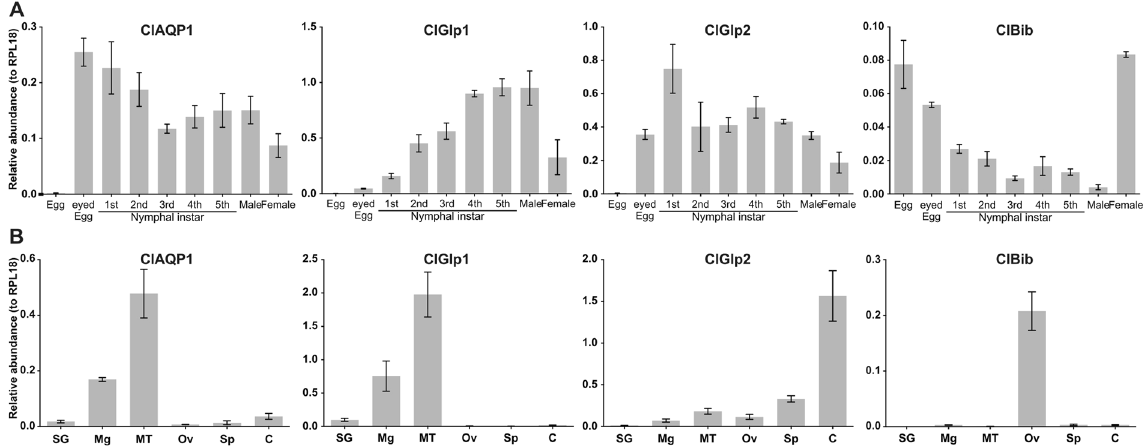
Figure 2. Lifestage and tissue-specific expression of C . lectularius AQP-like genes quantified by quantitative real-time PCR. ( A ) Lifestage-specific expression. ( B ) tissue-specific expression in adult female bugs. ClAQP1 and ClGlp1 have almost superimposable expression patterns, with primary expression in the gut and malpigian tubules. ClGlp2 is primarily expressed in the carcass. ClBib is only expressed in the ovaries. SG = salivary glands, Mg = midgut, MT = malpigian tubules, OV = ovaries, Sp = spermalege, C = carcass. The graph shows mean ± SD.